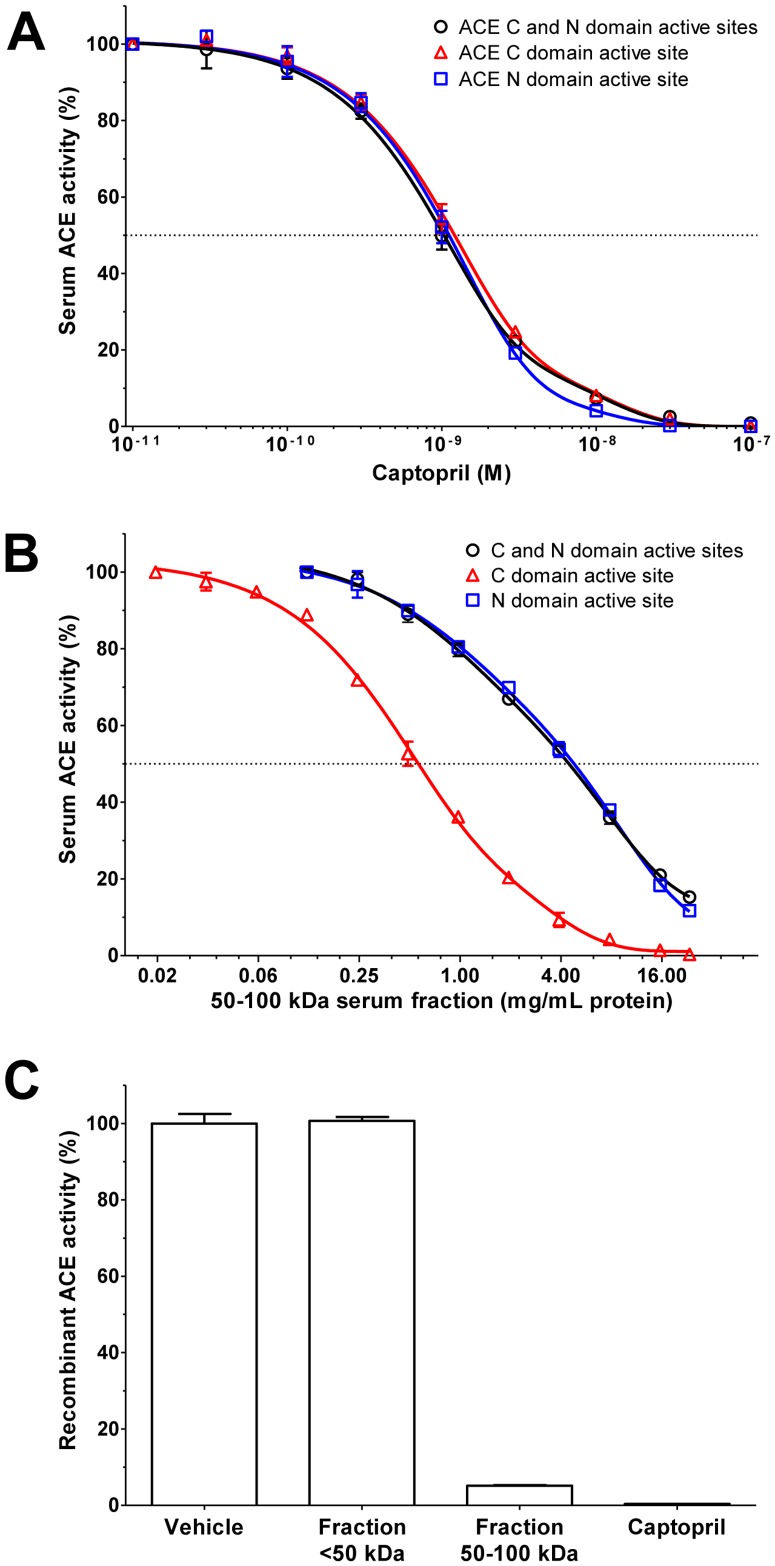
The endogenous ACE inhibitor has higher affinity at the C-terminal active site of ACE.Inhibition of serum ACE was tested by active site specific flourescent substrates: (Abz-SDK(Dnp)P-OH (triangles) for the N-terminal active site, Abz-LFK(Dnp)-OH (squares) for the C-terminal active site). Abz-FRK(Dnp)P-OH (circles) was used as non-site specific substrate. Captopril (0.01 nM–100 nM, A) concentration-dependently inhibited serum ACE activity determined by all three substrates with a similar affinity. In contrast, serum fraction containing 50–100 kDa components (0.02–20 mg/mL protein concentration, 20 mg/mL represents 2.34-fold dilution, B) had higher affinity at the C-terminal active site (determined by Abz-LFK(Dnp)-OH). Symbols represent means ± SEM of 3 independent determinations, values are given in the percentage of control (without ACE inhibitor). Inhibitory activity of the serum fractions (proteins below 50 kDa, or in the range of 50–100 kDa, 2-fold dilution) and captopril (1 µM) were selectively tested by the Abz-FRK(Dnp)P-OH substrate (non-site specific flourescent substrate, C). Bars represent means ± SEM of the recombinant ACE activities in the percentage of vehicle (n = 3).